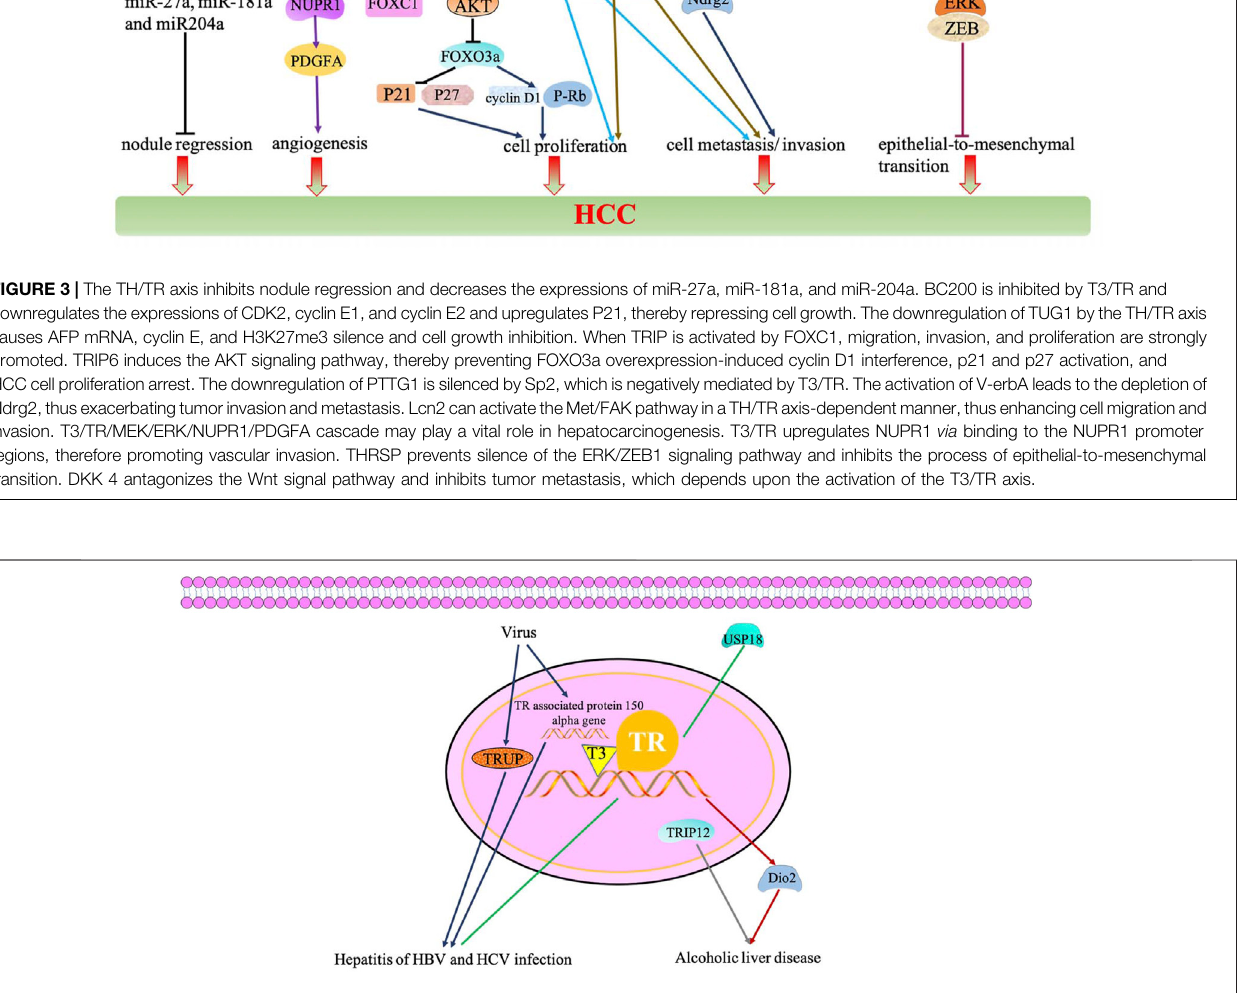
Frontiers in Pharmacology |